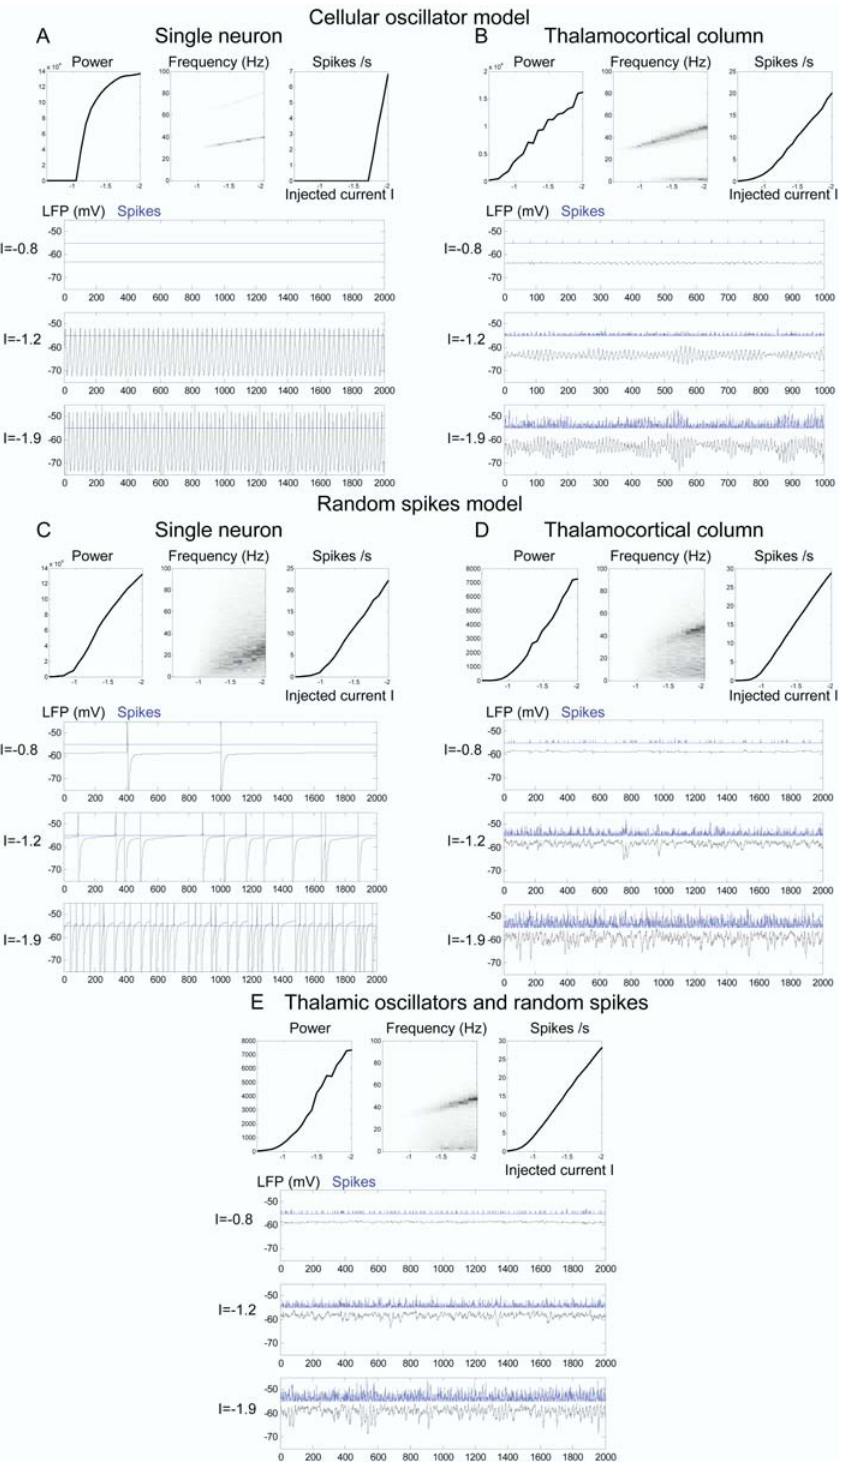
Figure 2. Characterizing the Transition Toward Spontaneous Activity In each panel, we show the evolution of the power of the local field potential (top left of each), frequency (top center), and mean firing rate of pyramidal neurons (top right) as a function of the injected neuromodulatory current I neuromodul . The elongated graphs give examples of the temporal evolution of the local field potential (bottom trace) and spikes (top trace) as a function of time in milliseconds for three different levels of I neuromodul . The simulations were performed with a single neuron (A and C) or with a whole thalamocortical column (B, D, and E), and with different sources of spontaneous activity: intrinsic cellular oscillations (A and B), random spikes (C and D), or both random spikes and intrinsic thalamic oscillators (E). Regardless of the exact mechanism, the architecture of thalamocortical columns created a bifurcation characterized by the sudden emergence, at a relatively constant threshold current, of high-frequency oscillations in the gamma range ( . 20 Hz), with continuously increasing power as a function of I neuromodul . DOI: 10.1371/journal.pbio.0030141.g002 PLoS Biology |